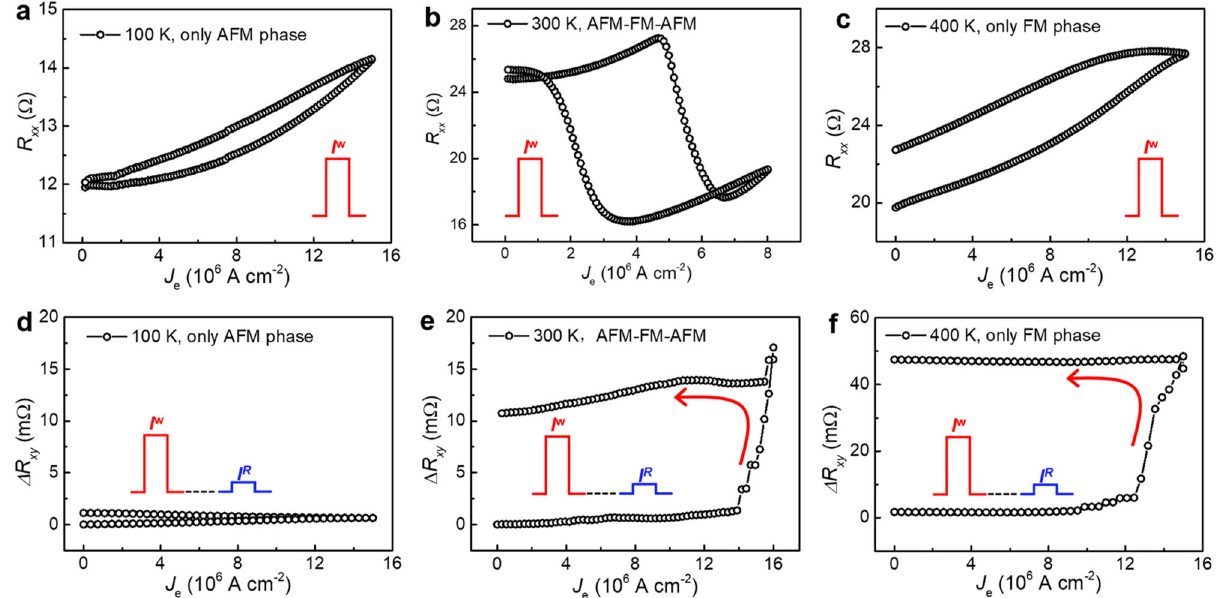
Fig. 3 Temperature dependence of Néel vector switching. a – c Longitudinal resistance R xx as a function of the writing current J e (single pulse measurement) at a different base temperature of 100, 300, and 400 K, respectively; indicating that the only AFM phase at 100 K ( a ), AFM – FM – AFM phase transition at 300 K ( b ), and the only FM phase at 400 K ( c ), within the writing current density below 15 × 10 6 A cm − 2 . d – f Current-driven Néel vector switching (2-pulses measurement) at 100 K (only AFM phase), 300 K (AFM – FM – AFM phase), and 400 K (only FM phase), contrast, the switching threshold in the FM phase remains a S constant independent of , as shown in Fig. 5d. The switching 2 S 1 thresholds of the two phases approach the same in the limit S ! 0 ( i.e ., one sublattice spin vanishes). 2 S 1